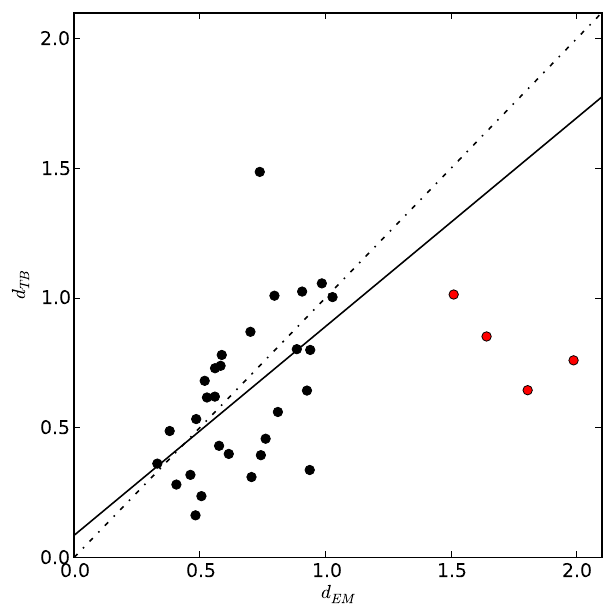
Fig. 7. Scatterplot d TB and d EM for interpolated averages along the track shown in Fig. 6. Each point represents an average over a section of about 1200m which is similar to the doubled 3dB footprint of the EMIRAD instrument. A linear regression yield d TB = 0 . 8 d EM + 0 . 08m with a standard error of 0.16 and a cor- relation coefficient of r = 0 . 5 by including only the values with d EM < 1 . 5m (black dots). The correlation decreases to r = 0 . 1 by including also the values d EM > 1 . 5m (red